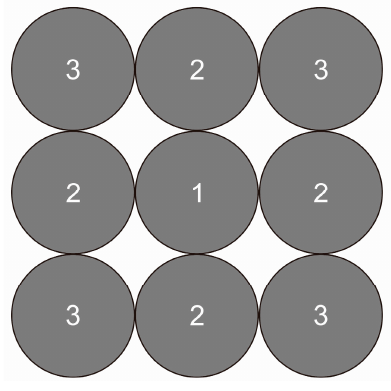
Figure A3. 2-Dimension sketch of receptors (grey circles) for the particle backscattering ratio x u or forward scattering ratio x d